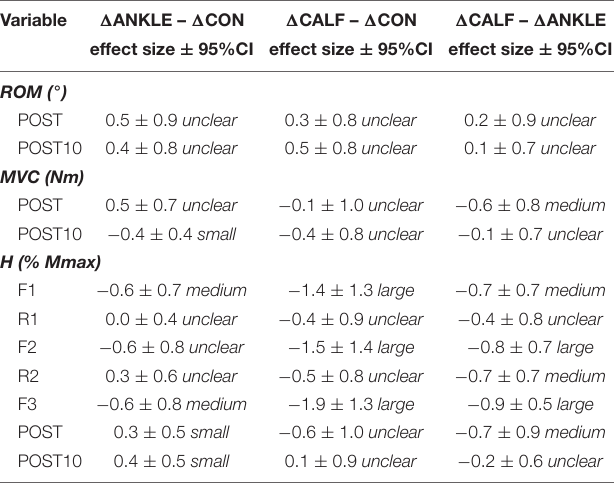
TABLE 3 | Cohen’ d effect size and 95% confidence